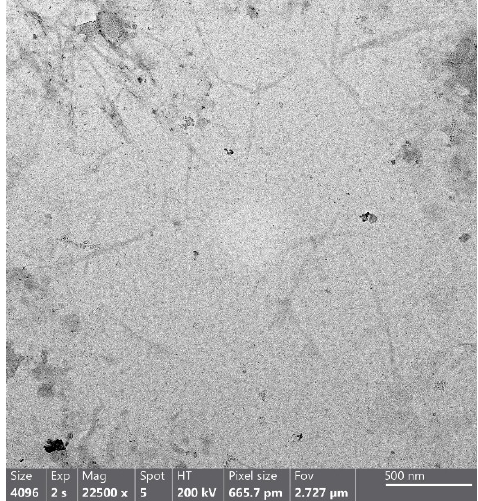
Figure 2. TEM image of cellulose nanocrystals (CNCs) from orange peels.